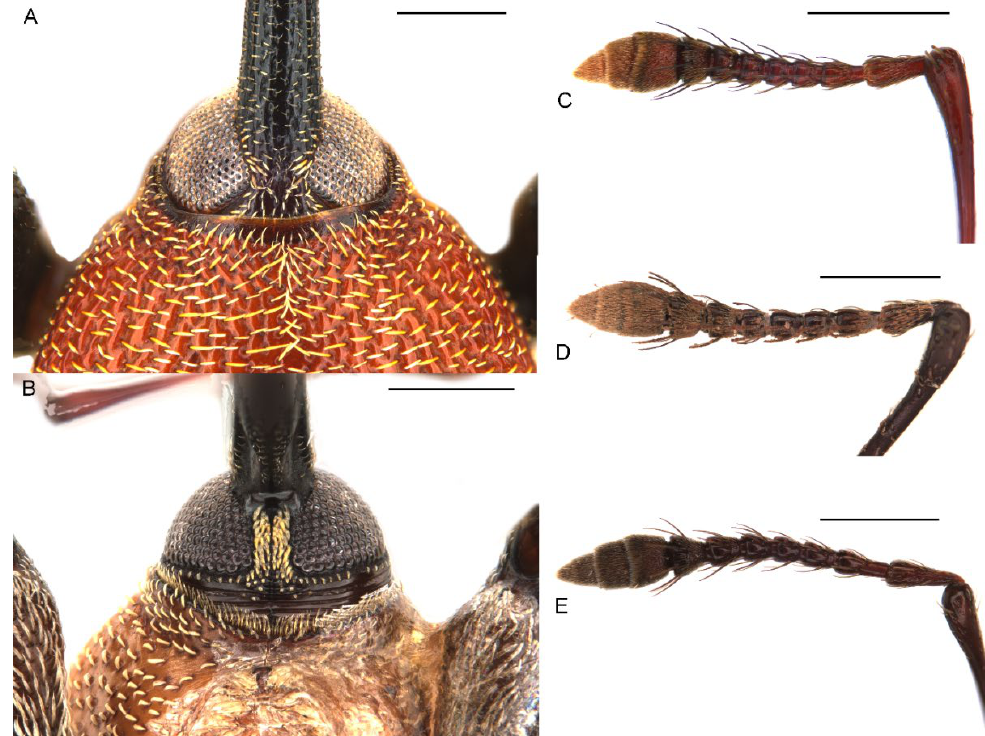
Figure 3. Diagnostic external characters of Miltotranes : ( A ) M. prosternalis , head and base of rostrum, dorsal view; ( B ) ditto, ventral view; ( C ) M. prosternalis , right antenna, dorsal view; ( D ) M. subopacus , ditto; ( E ) M. wilsoni sp. n., ditto. Scale bars: 0.5 mm.